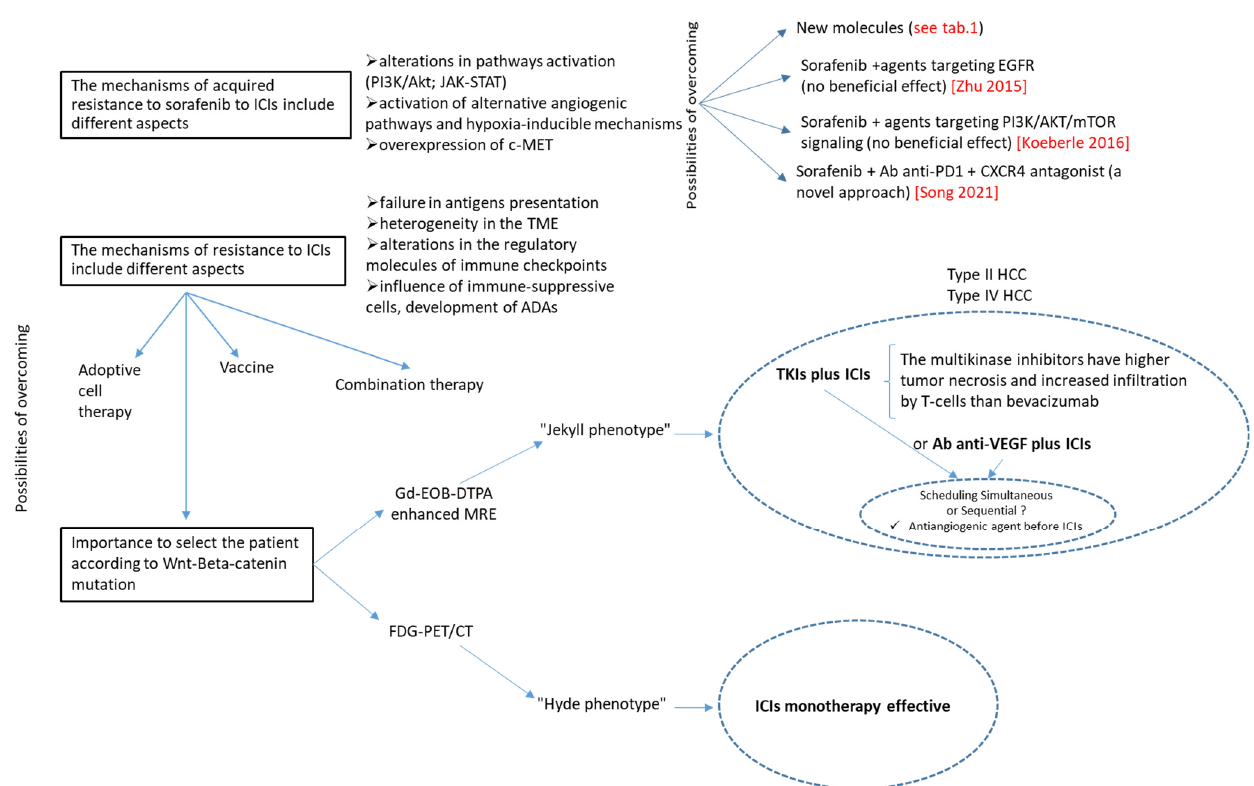
Figure 4. How to overcome the resistance: an overview. This schematic representation underlines the open questions about resistance to antiangiogenic therapy and immunotherapy and the possibilities of overcoming them as well as the importance of stratifying patients into different subtypes to achieve higher response rates. Abbreviations: c-MET, c-mesenchymal-epithelial transition receptor; PI3K/Akt, phosphatidylinositol-3-kinase/Akt; mTOR, mammalian target of rapamycin; ADAs, anti-drug antibodies; EGFR, epidermal growth factor receptor; PD-1, programmed cell death; CXCR4, CXC chemokine receptor type 4; TKI, tyrosine kinase inhibitor; ICIs, immune checkpoint inhibitors; Gd-EOB-DTPA enhanced MRE, gadolinium-ethoxybenzyl-diethylenetriamine-enhanced magnetic resonance; FDG-PET/CT, fluoro-2-deoxy-D-glucose-PET/CT.